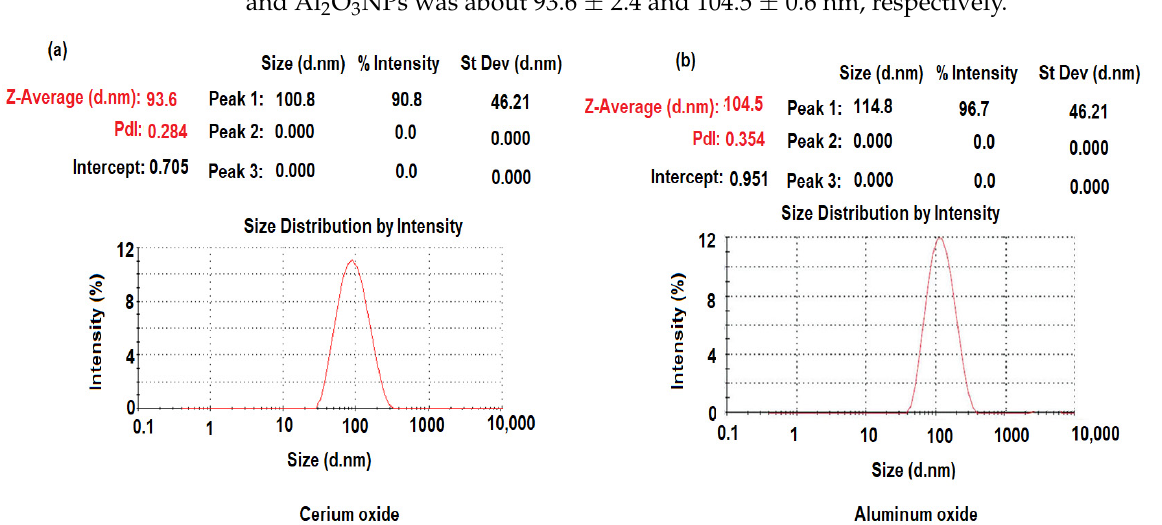
19.58% and 66.65%,